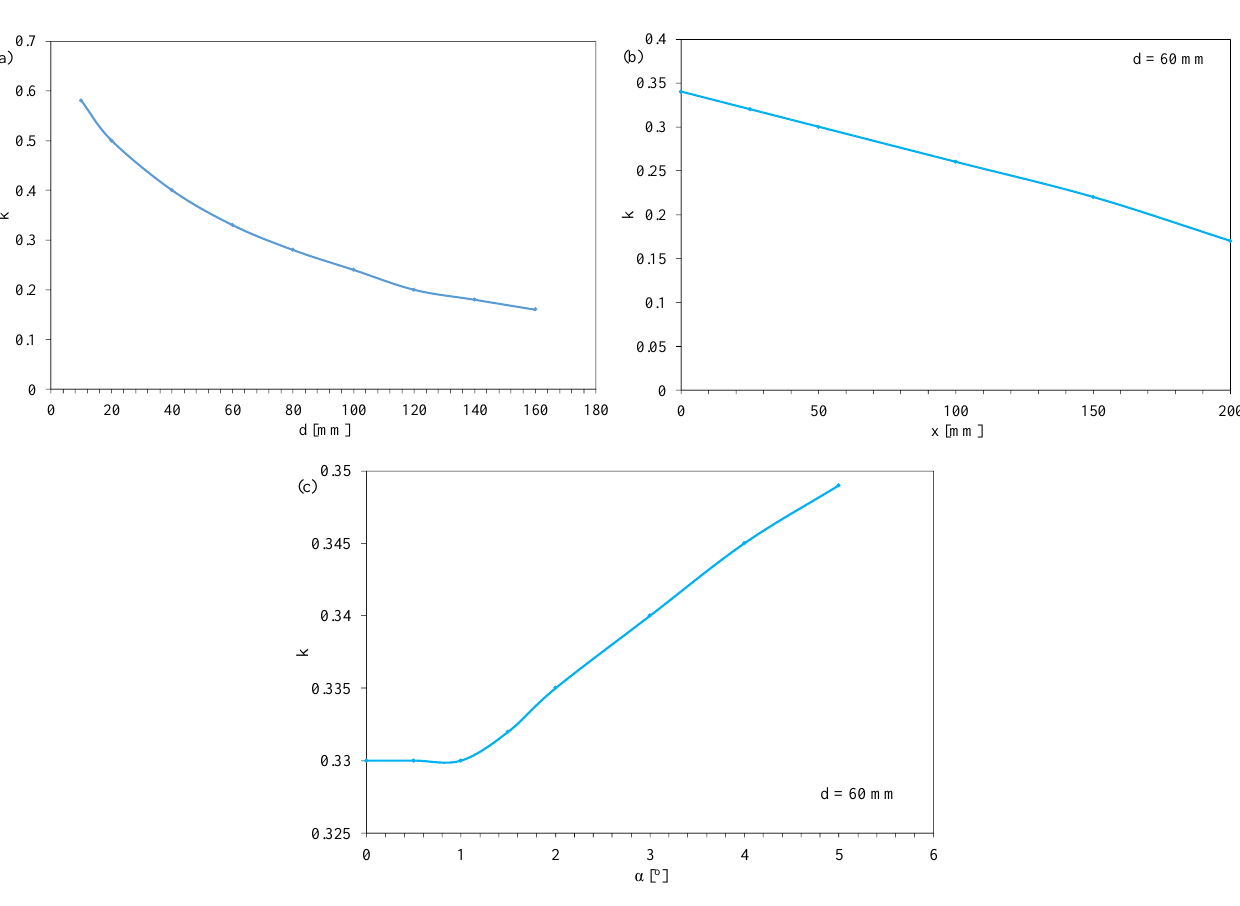
Figure 5. Influence of changing the horizontal position ( a ), vertical position ( b ), and the angle ( c ) of the transmitting and receiving coils with a rectangular cross-section on the coupling factor.